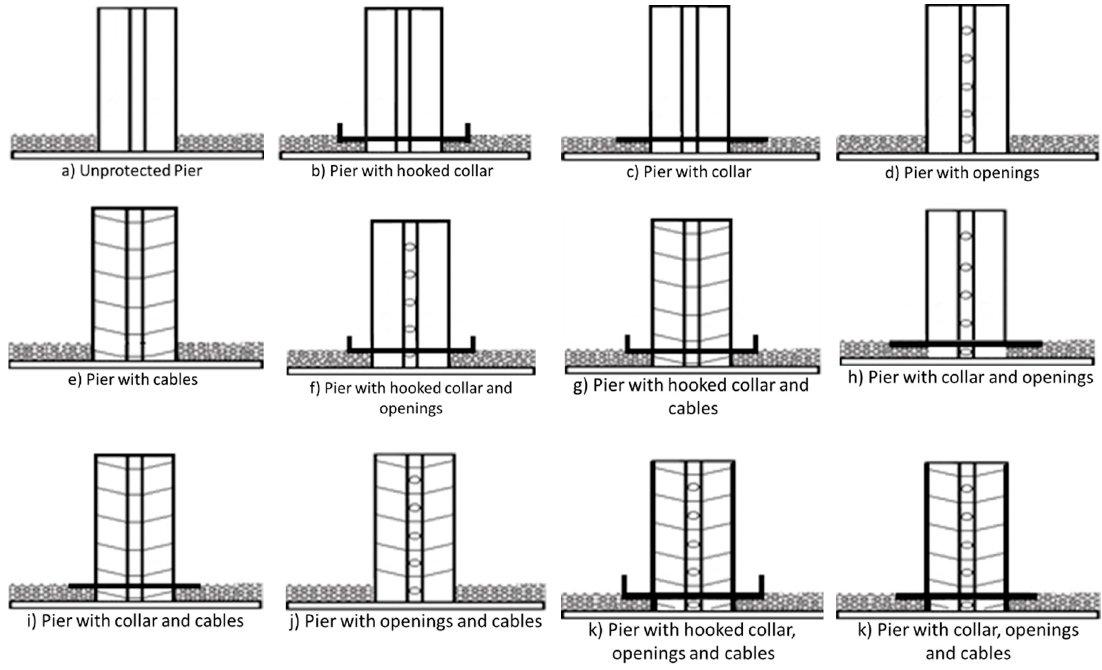
Figure 2. Details of pier modification around an octagonal pier.